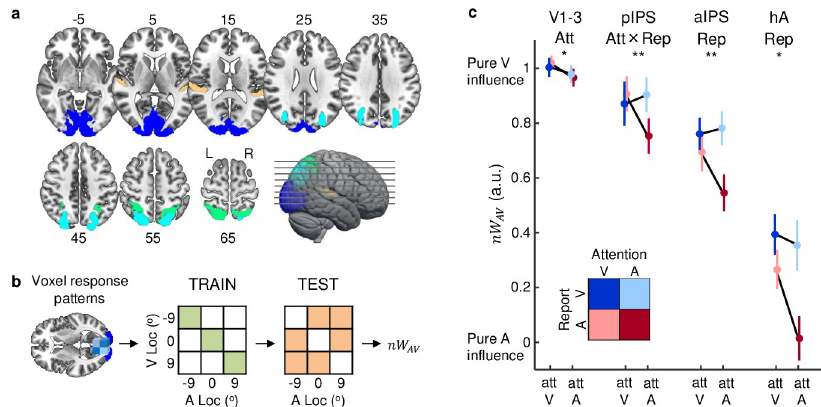
Fig 4. Neural audiovisual weight index ( nw ) across the audiovisual processing hierarchy. (a) fMRI voxel AV response patterns were obtained from anatomical ROIs along the visual and auditory dorsal cortical hierarchies: V1-3 (blue), pIPS (cyan), aIPS (green), and hA (orange). ROIs are displayed on a canonical brain. (b) An SVR model was trained to learn the mapping from the fMRI voxel response patterns to the external spatial locations based on the audiovisual spatially congruent trials (green cells = congruent). The learnt mapping was then used to decode the spatial location from the fMRI voxel response patterns of the audiovisual spatially incongruent trials (orange cells = incongruent) to compute nw AV . (c) Across participants’ mean nw AV ( ± SEM) shown as a function of (i) prestimulus attention (Att): auditory/attA versus visual/attV; and (ii) poststimulus report (Rep): auditory/repA